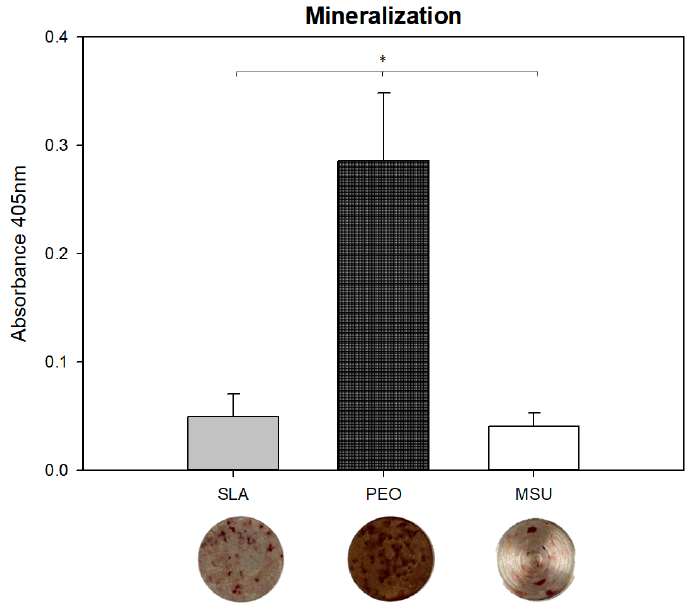
Figure 6. Mineralized matrix formation in the SLA, PEO and MSU surfaces. * represents a significant difference between surfaces ( p < 0.05). The bottom images show the mineralized nodule formation on each surface.